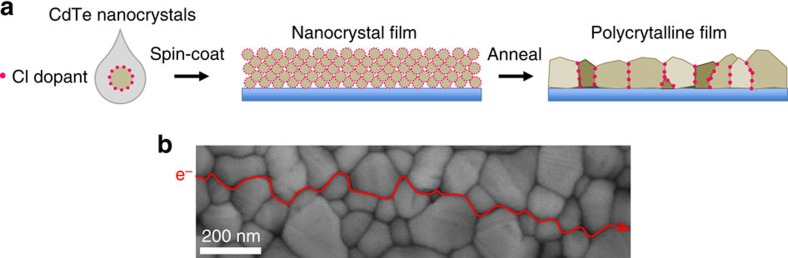
Materials design and fabrication.(a) Schematic of the fabrication of a polycrystalline film from colloidal CdTe nanocrystals. Chloride-capped CdTe colloidal nanocrystals were spin coated onto a substrate forming a film, which was subsequently annealed at 350 °C in an argon environment for 0.5–5 min. (b) Scanning electron microscopy (SEM) image of the polycrystalline film. Red line and arrow represent a pathway along GBs for electron percolation.